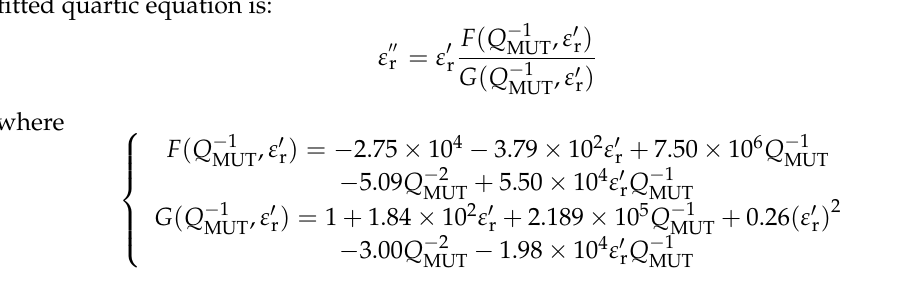
and tan δ under different ε (cid:48) r MUT